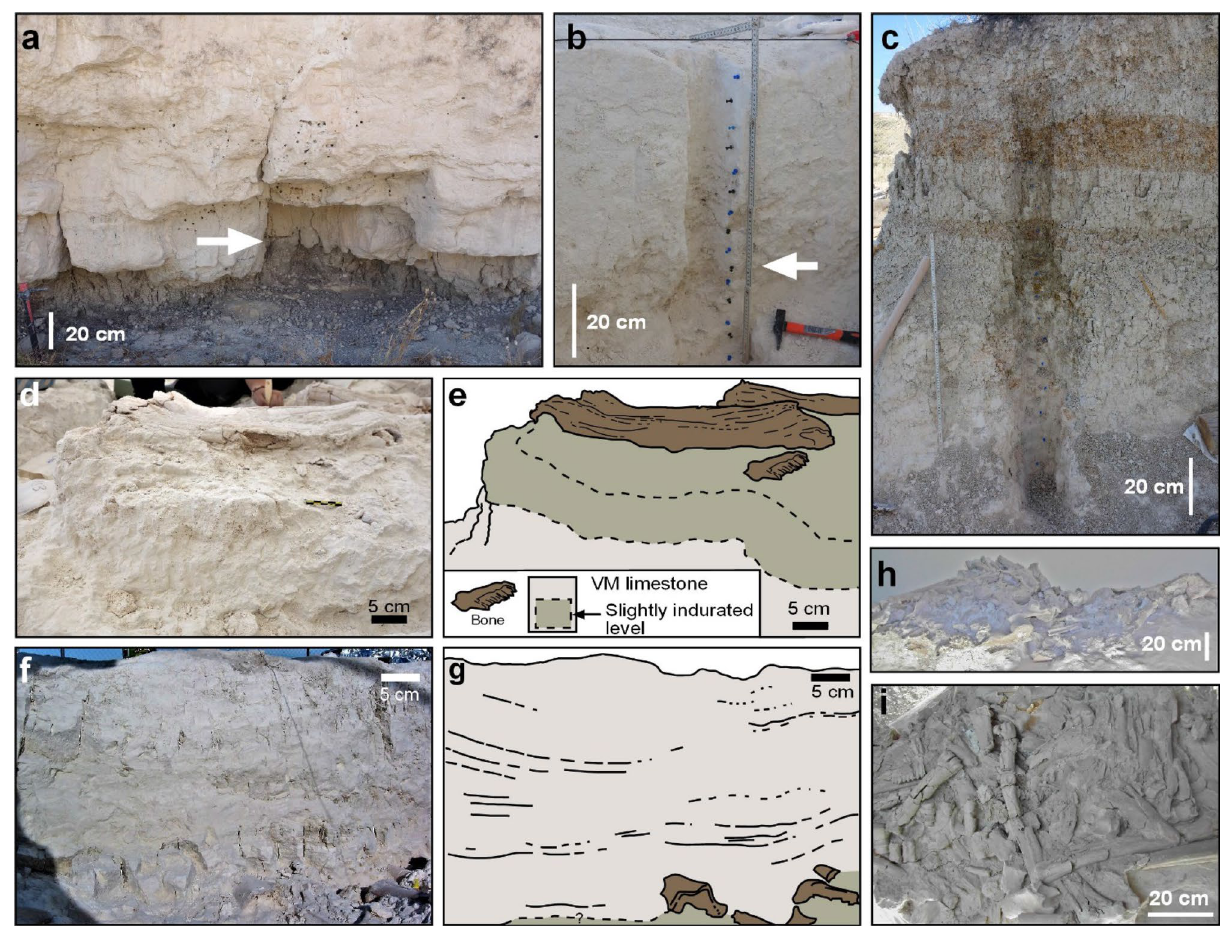
Figure 3. ( a ) Contact (arrow) between intervals C0 and C1 in section VM1. ( b ) Intervals C1 and C2 in section VM4 (arrow points to the limestone with subtle induration in Fig. 4b). ( c ) Unit D in section VM4. ( d , e ) Interval C1 in section VM4, showing large bones (a cervid horn, among others) on top of a level with subtle induration (also indicated in Fig. 1b). ( f , g ) Upper interval C1 and C2 in section VM3, displaying subtle stratification and lamination within C2. ( h , i ) Bone accumulation at site VM-3 in lateral and plane vertical view, respectively (as displayed at Orce Museum). Photographs ( a – d ) were taken by the authors in 2017, and ( f – i ) in 2005. The scale in Fig. a, h and i is